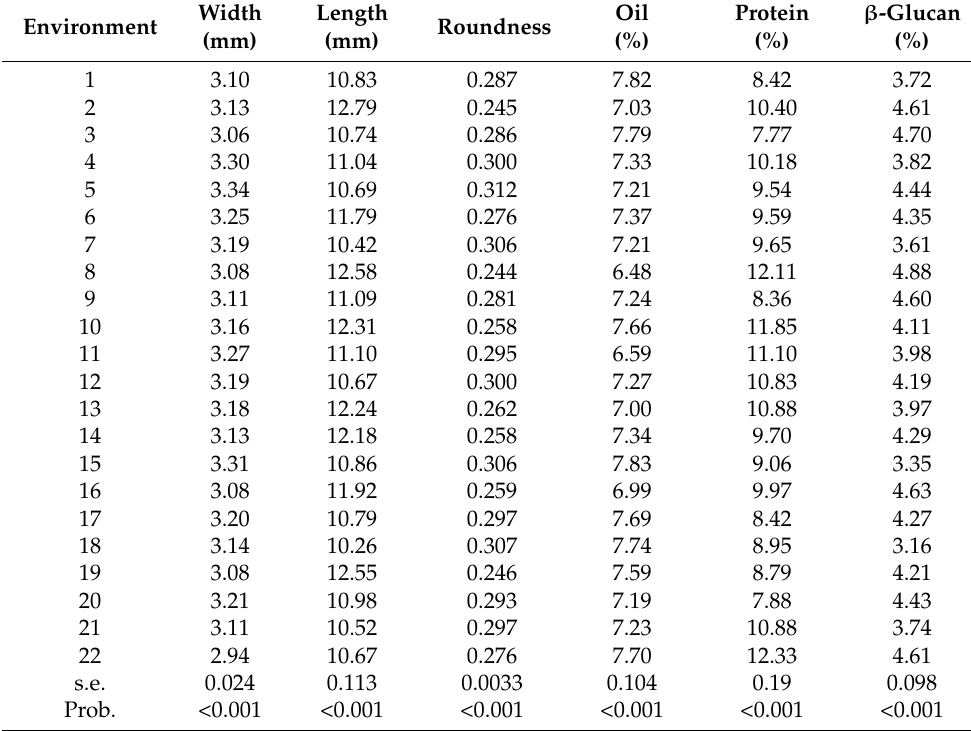
Table 4. Effect of environment on grain dimensions (width, length and roundness) and grain composition (oil,%; protein,% and β -glucan, %). Data are presented as the mean of four winter oat varieties grown in each environment.